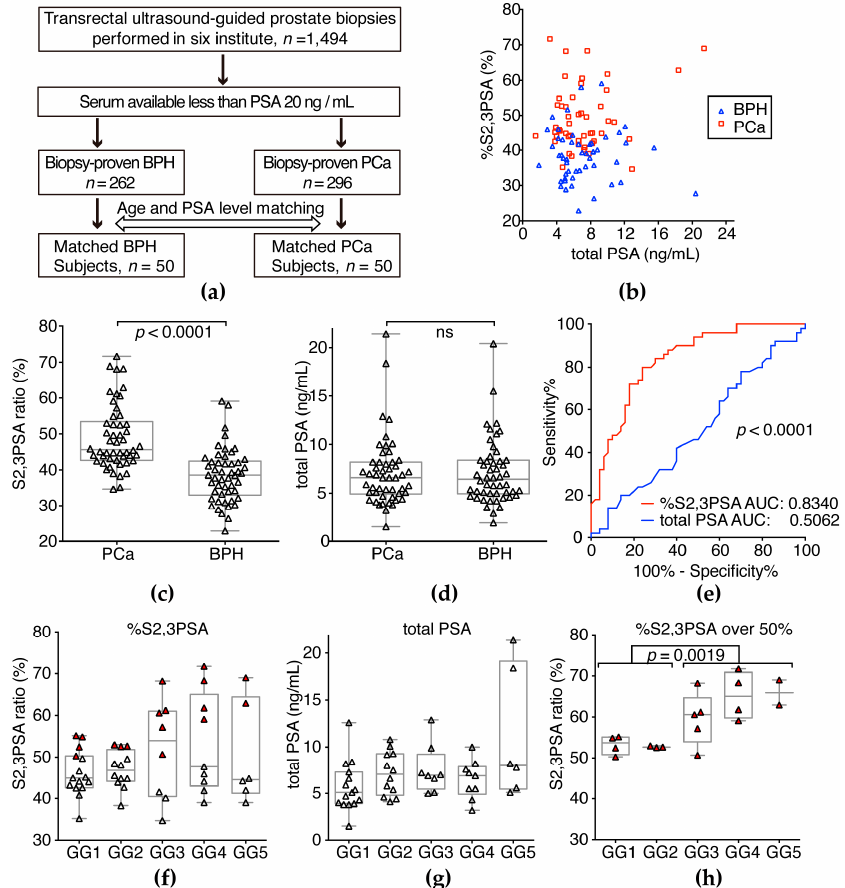
Figure 6. Serum %S2,3PSA and total PSA level in the validation sample set. ( a ) Fifty patients with PCa were pair-matched for age and PSA level with the same number of patients with BPH; ( b ) Correlations between %S2,3PSA and total PSA value in patient serum samples; ( c ) Serum %S2,3PSA was significantly higher in patients with PCa than BPH ( p < 0.0001). The grand mean represents the overall mean of the Y variable; ( d ) Serum total PSA was not significantly different between PCa and BPH ( e ) Receiver operating characteristics (ROC) curve analysis for detection of PCa showed that the areas under the curve (AUC) for %S2,3PSA and conventional total PSA tests were 0.8340 and 0.5062, respectively; ( f ) %S2,3PSA among PCa patients classified by the Pbx GG; ( g ) total PSA level of PCa patients classified by the Pbx GG. Red triangle indicates %S2,3PSA over 50%; ( h ) Comparison between Pbx GG ≤ 2 and Pbx GG ≥ 3 patients that had an %S2,3PSA ratio over 50% ( p = 0.0019).